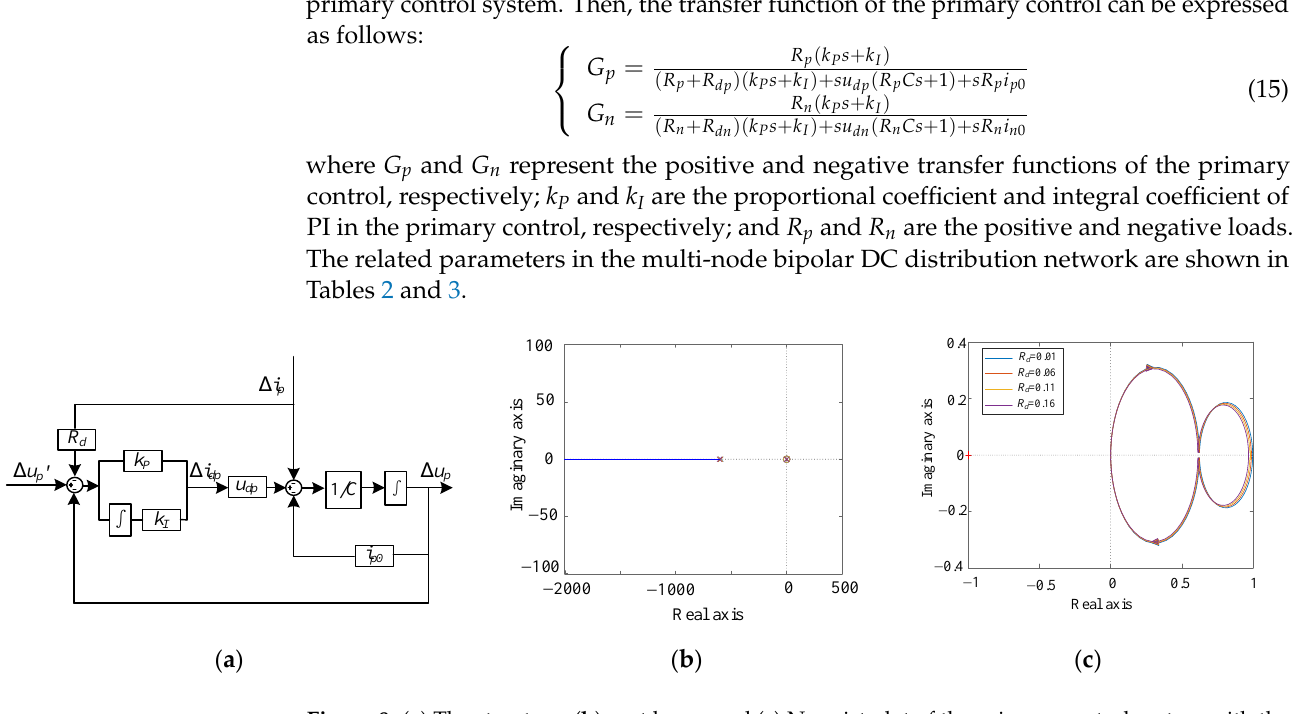
Table 2. The parameters of the bipolar DC distribution network.